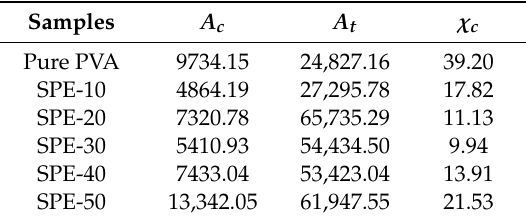
Figure 2. Represented the deconvoluted XRD peaks for ( a ) pure PVA, ( b ) SPE-10, ( c ) SPE-20, ( d ) SPE-30, ( e ) SPE-40, ( f ) SPE-50. The graphs show the peaks for both the crystalline and amorphous regions. The inner graph depicts the crystalline peaks only. (The solid lines represent the sum of the Gaussian fits in dotted lines). Table 1. Crystalline, total area, and degree of crystallinity ( χ c ) for pure PVA and PVA/NH 4 NO 3 proton-conducting SPE films.